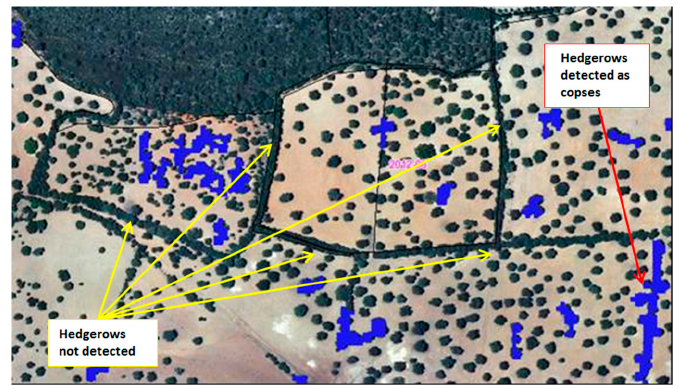
Figure 13. Limitations in hedgerows detection.